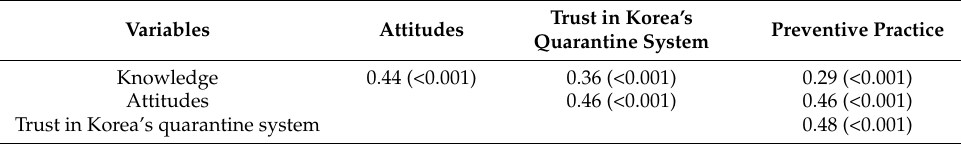
Table 4. Correlations among variables ( N =